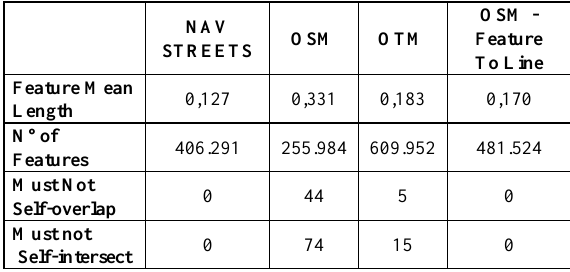
Table 4. Comparison of mean feature length and topology